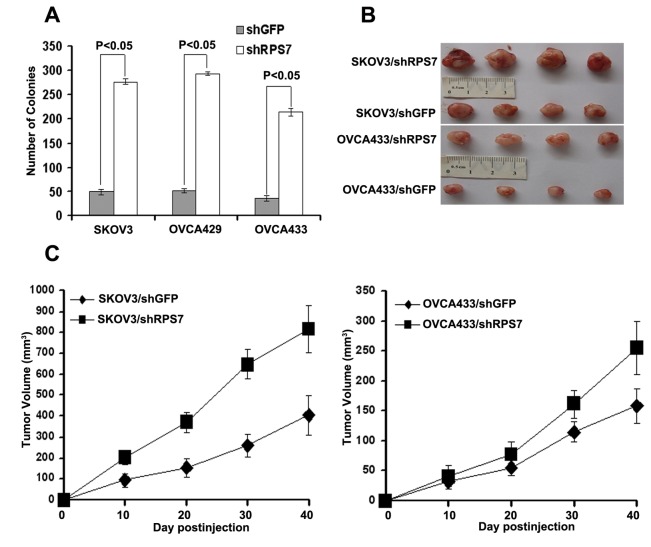
Xenograft tumor burden in mice with or without silencing of RPS7.
A, In vitro tumorigenicity tested by soft agar assay (P < 0.05). Error bars = 95% CIs. B, In vivo tumorigenesis examined by animal assay. C, Subcutaneous tumor growth from mice injected with cells expressing either shGFP or shRPS7 (P < 0.05). Error bars = 95% CIs.